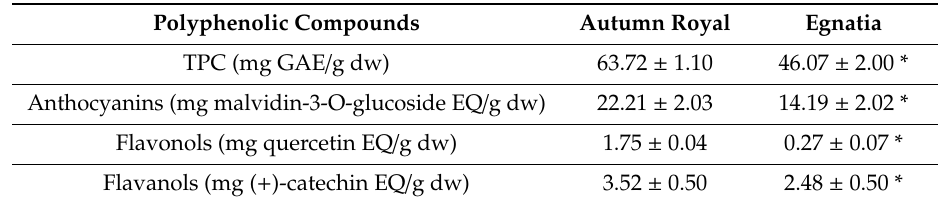
Table 1. TPC (total phenolic content) and polyphenolic profile (anthocyanins, flavonols, and flavanols) of Autumn Royal and Egnatia